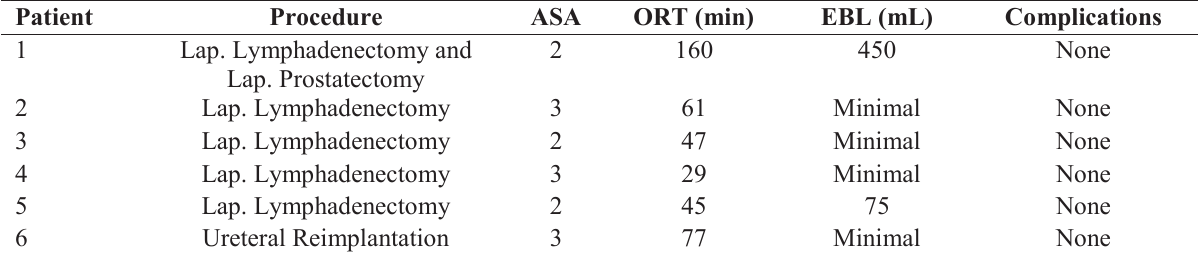
Table 2 - Peri-Operative Data.